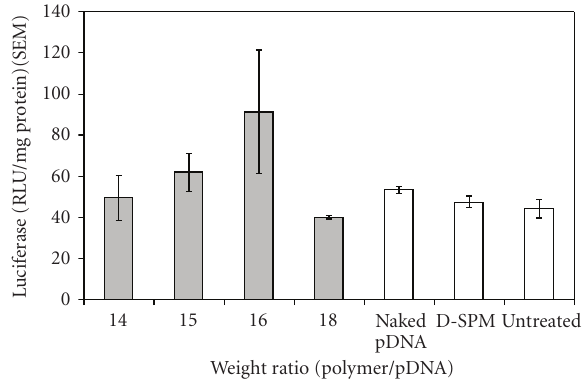
Figure 5: Luciferase expression (RLU/mg protein) in the trachea and lung of BALB/c mice following administration of naked pCIKLux, dextran-spermine only (D-SPM), and various weight- mixing ratios of D-SPM/pCIKlux complexes ranging 14 to 18 at 2 days posttreatment. The amount of DNA was kept to 10 μ g. Untreated mice was served as the control. Data are presented as mean ± S.E.M from 6 animals.